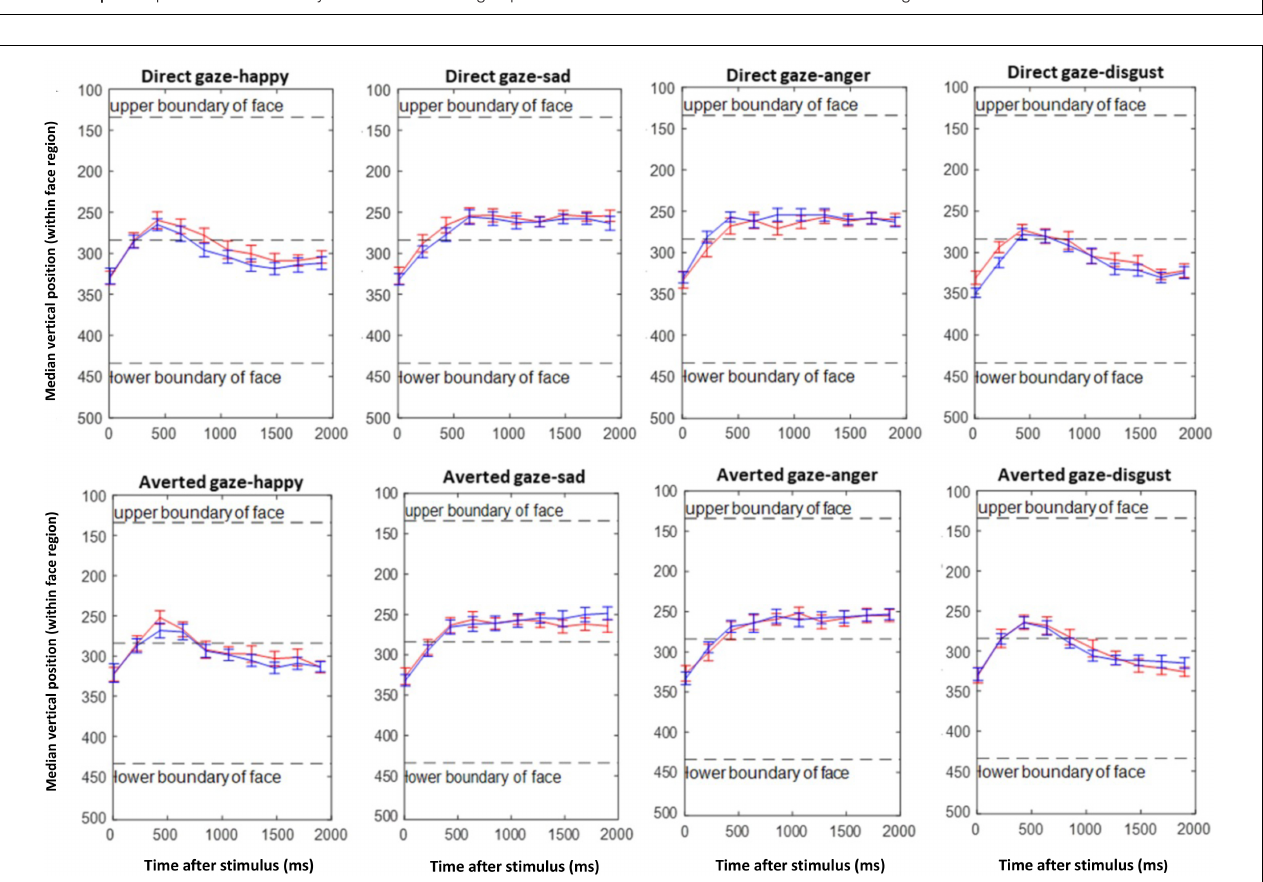
FIGURE 7 | Emotion composite task. Mean of median vertical gaze positions of the ASD (red) and TD (blue) groups during the first 2 s after stimulus presentation in consecutive time bins of 200 ms.